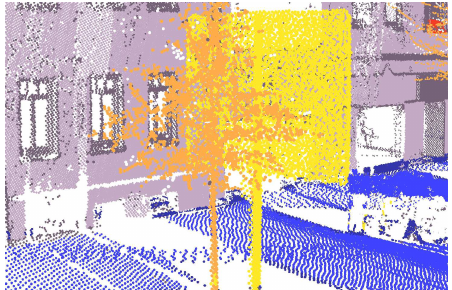
Figure 11. Example of a correctly separated traffic sign and a